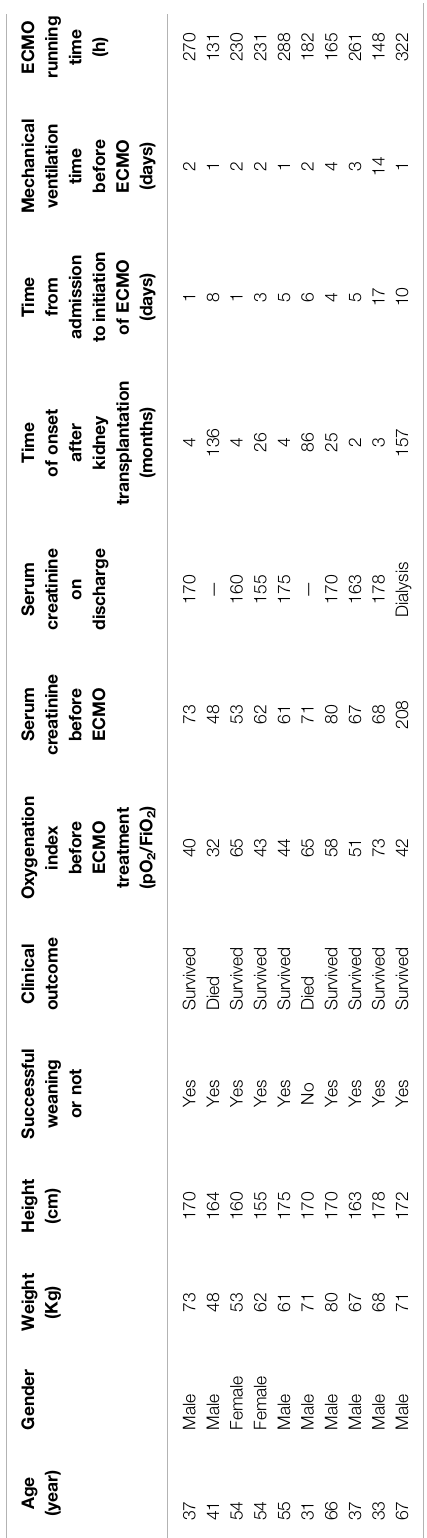
FIGURE 1 | The alveolar lavage fl uid was collected for examination, and the images of P. jirovecii pneumonia trophozoites were obtained by Gomori ’ s methenamine silver